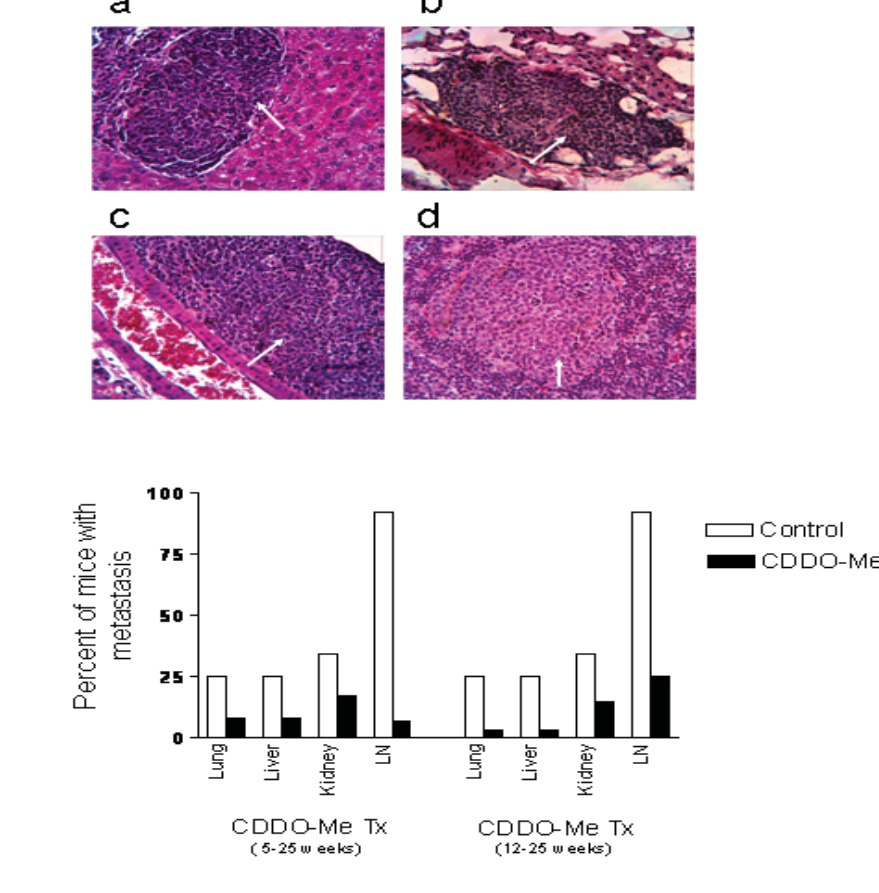
Figure 5. Effect of CDDO-Me on metastasis of CaP. (A) . H&E-stained sections of liver (a), lung (b), kidney (c) and pelvic lymph node (d) of 25 wk old control TRAMP mice showing metastatic lesions (arrows) × 250 magnification; (B) . Bar graph showing the incidence